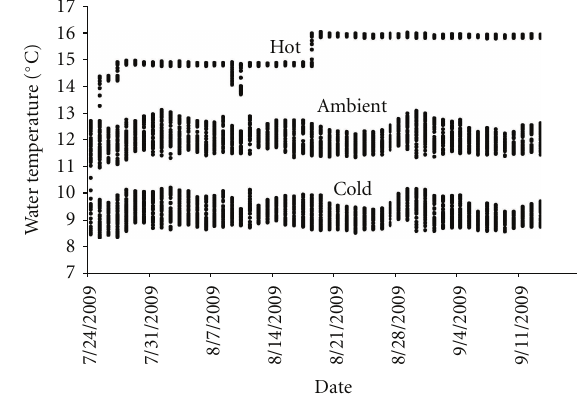
Figure 1: Experimental water temperatures over the course of the study. Ambient water from Puget Sound (mean = 12.0 ◦ C) was heated and chilled in head tanks to obtain the “hot” (mean = 15.0 ◦ C) and “cold” (mean = 9.5 ◦ C) treatments,